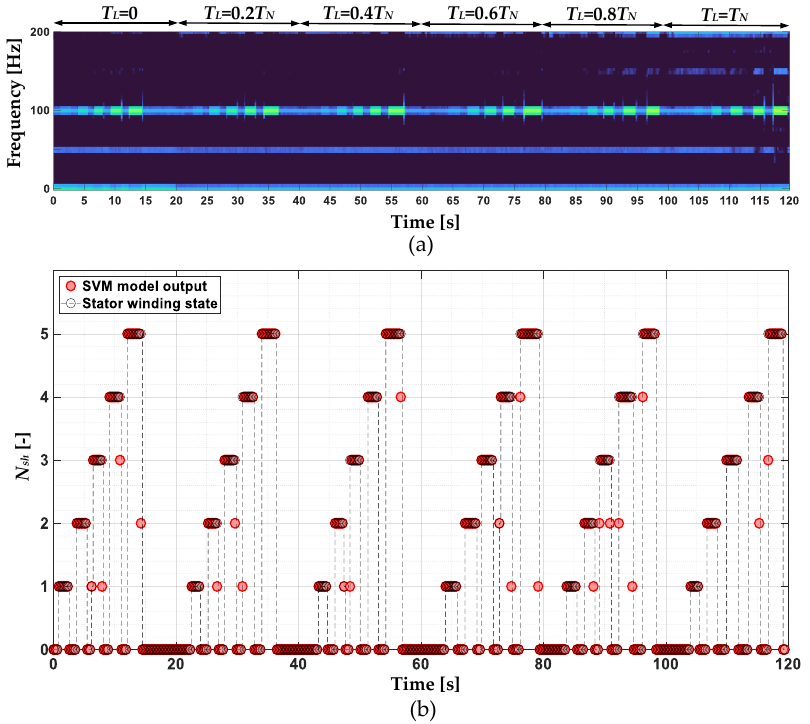
Figure 24. ( a ) Part of the stator phase current negative sequence component STFT spectrogram and ( b ) response of the SVM-based ITSC fault classifier.